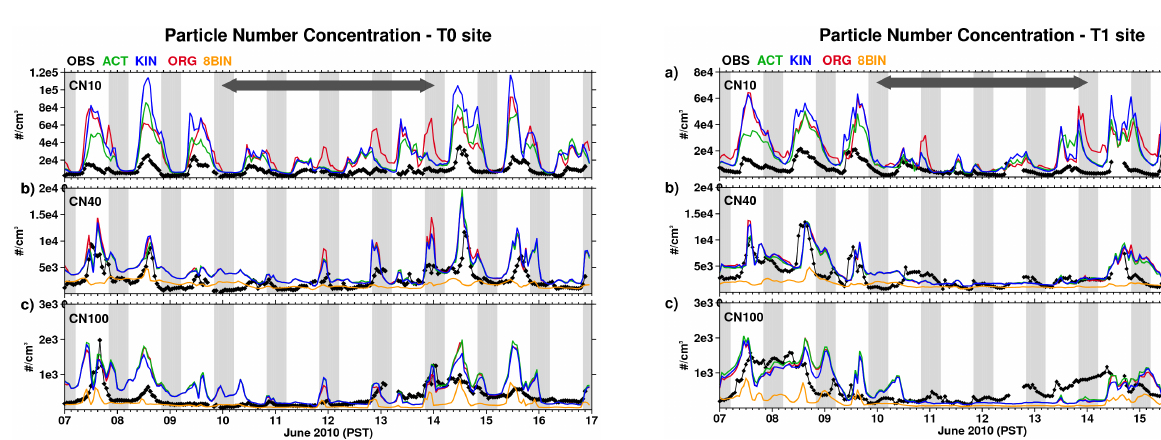
Figure 1. Observed and simulated time series of particle number concentration at the T0 site for (a) CN 10 , (b) CN 40 , and (c) CN 100 . Gray shading indicates nighttime and the arrow denotes the period of northerly synoptic flow associated with the passage of a trough over California. All times are local Pacific Standard Time (PST).